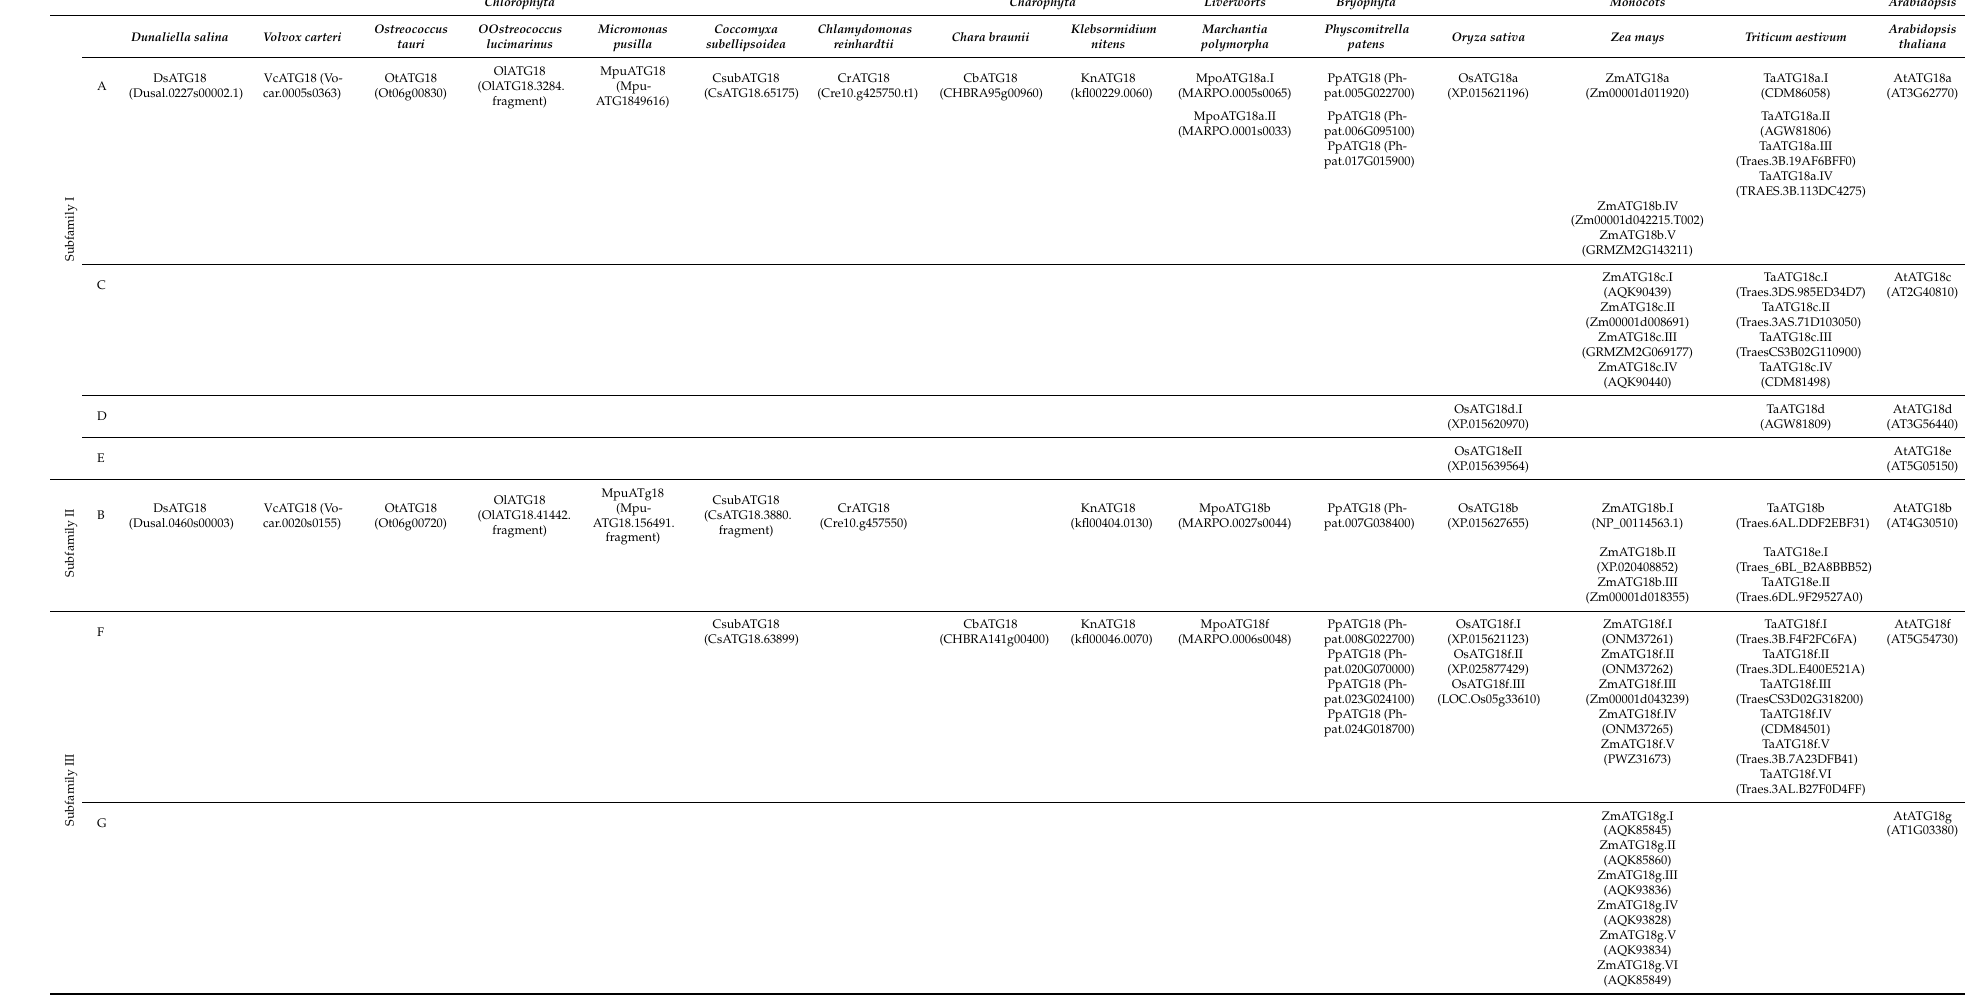
Table 2. List of ATG18 homologs in early plant